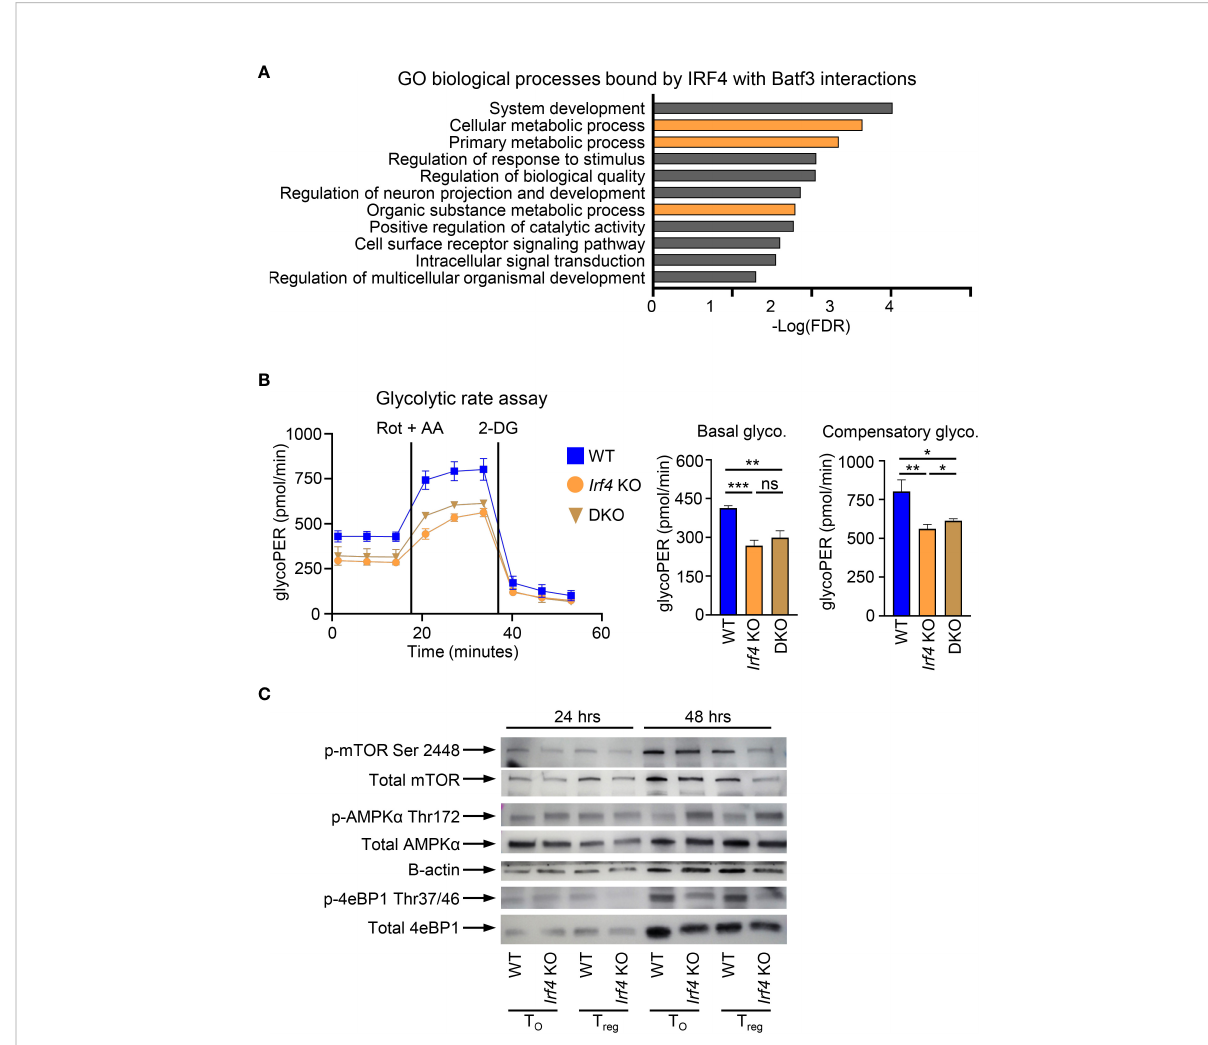
FIGURE 4 BATF3/IRF4 interactions necessary for maintenance of cellular metabolism upon T cell activation. (A) Gene ontology analysis of pathways enriched by BATF3/IRF4 interactions generated from list of genes bound by IRF4 only in Batf3 WT sample. Data presents all upregulate pathways with – Log(FDR) < 0.05. FDR calculated by Benjamini-Hochberg False Discovery Rate. Metabolic pathways highlighted in orange. (B) Glycolytic rate for CD4+ T cells activated and cultured for 48 hrs in T 0 conditions. GlycoPER represents proton ef fl ux rate due to glycolysis. Data represents mean and S.D. of 3 independent experiments, each consisting of 4-6 technical replicates averaged together. Statistical signi fi cance calculated using unpaired two-tailed Student ’ s T test for the three averages of the independent experiments. *p<0.05, **p<0.01, ***p<0.001, ns, not signi fi cant (p>0.05). (C) Western Blot of WT or Irf4 KO CD4+ T cells activated and cultured for 24 or 48 hrs in iTreg or T 0 conditions and stained for respective phosphorylated or total proteins. Representative of 2 independent